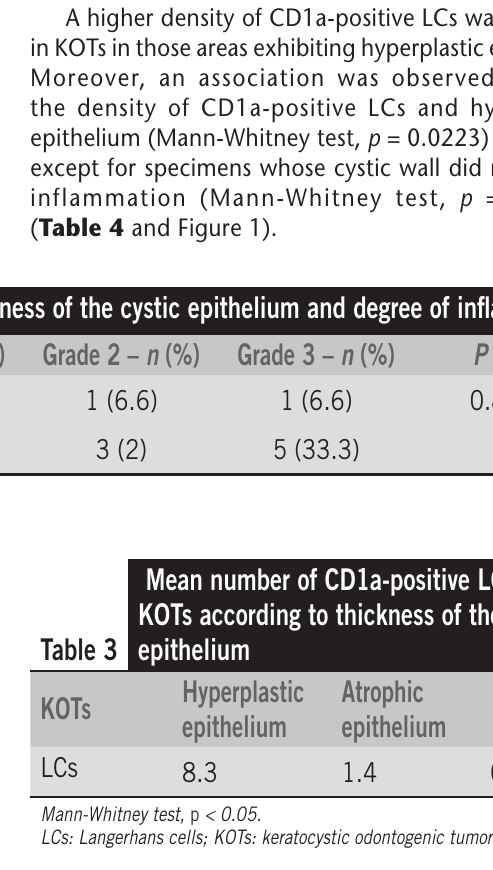
Mean number of CD1a-positive LCs in the epithelial lining of KOTs in the absence of inflammation Epithelium Positive cases – n